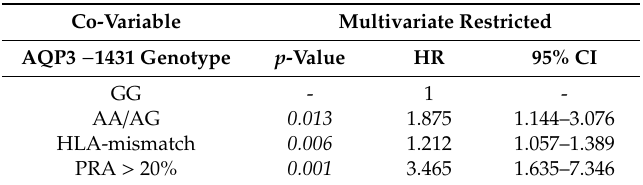
Table 4. Restricted multivariable Cox regression analysis of kidney transplantation recipients with respect to the e ff ect on graft rejection risk.